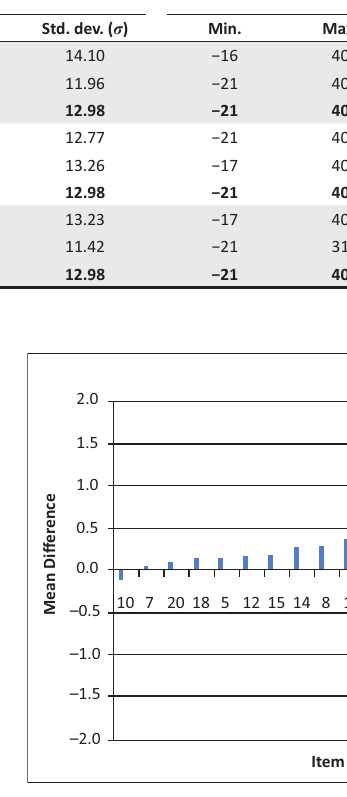
FIGURE 2: Mean shift in item average total scores of the subscales of the SROM between pre-test and post-test: experimental